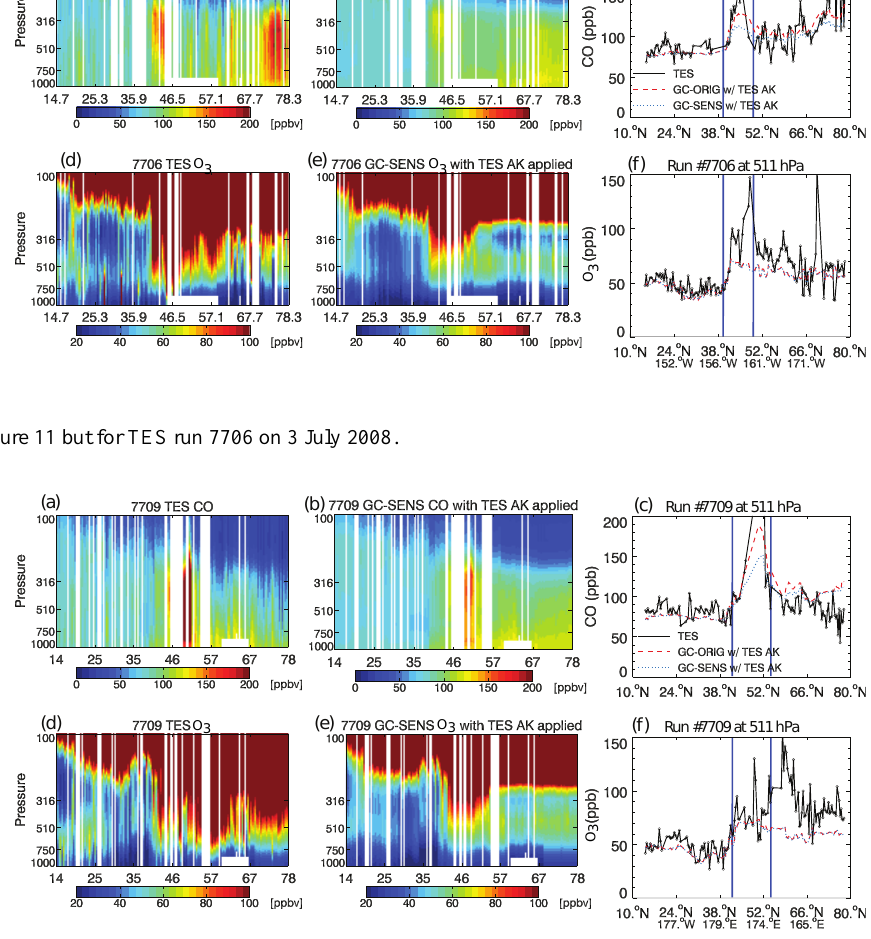
Fig. 14. Same as Figure 11 but for TES run 7709 on 4 July